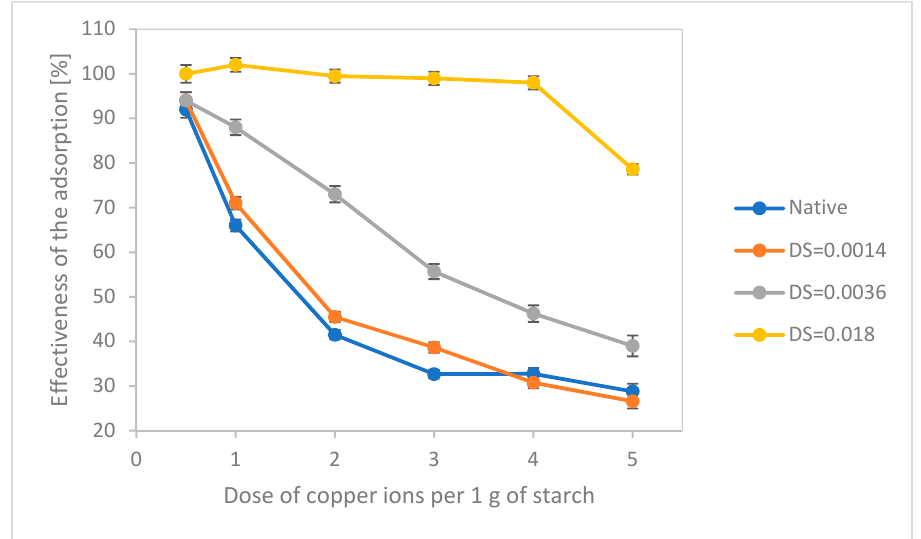
Figure 1. Effectiveness of the adsorption of copper ions by oxidised starches having different degrees of substitution ( n = 3).